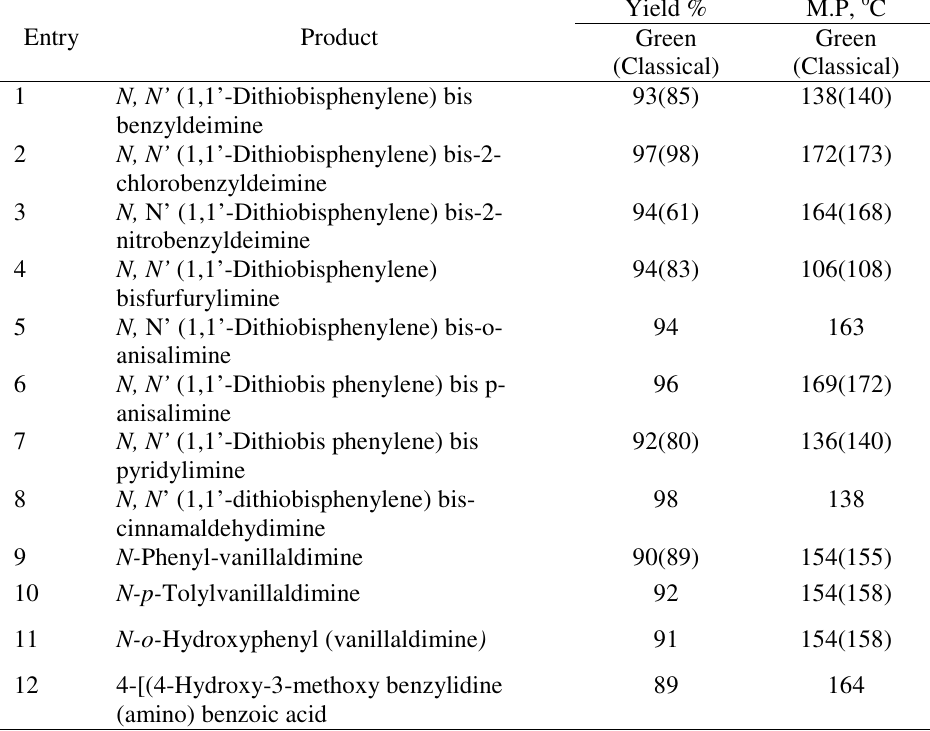
Table 1 . Solvent free synthesis of imines